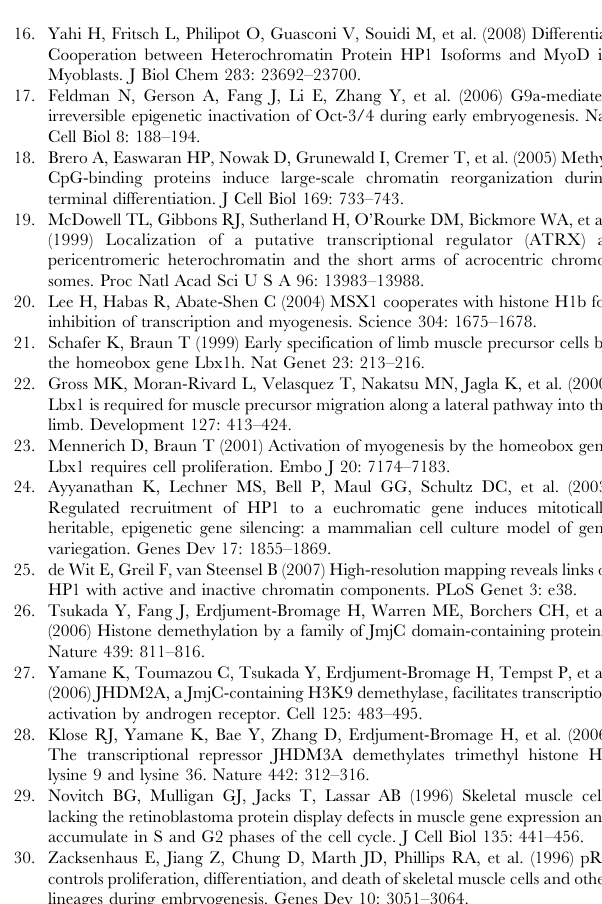
Figure S1 Confocal fluorescence microscopy was per- formed on C2C12 myoblasts and myotubes after immunostaining for the indicated HP1 protein (green) and DAPI (converted to red). Figure S2 C2C12 myoblasts were treated with EDU after indicated siRNA transfection. The cells were then fixed and stained for EDU incoperation and HP1a expression. Nuclei were visualized by DAPI staining. Figure S3 C2C12 myoblasts were co-transfected with indicated siRNA and GFP-expressing plasmid. GFP- expressing cells were isolated by FACS. Staining with 7-AAD was performed to exclude dead cells.